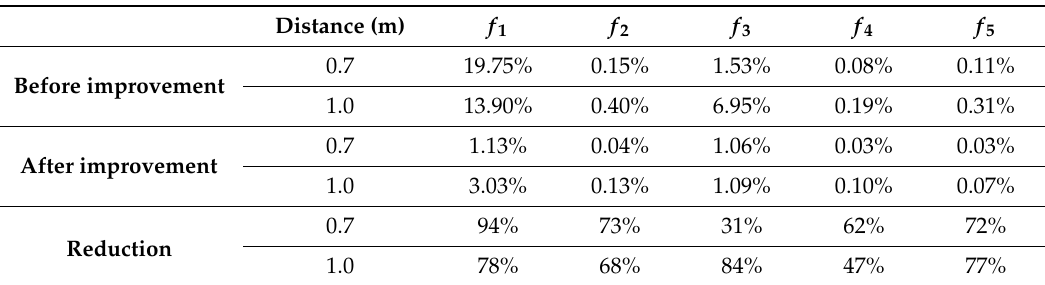
Table 1. Relative SD of the induced voltage at 0.7 m and 1 m from FG, before and after hardware improvement, and their relative reduction.